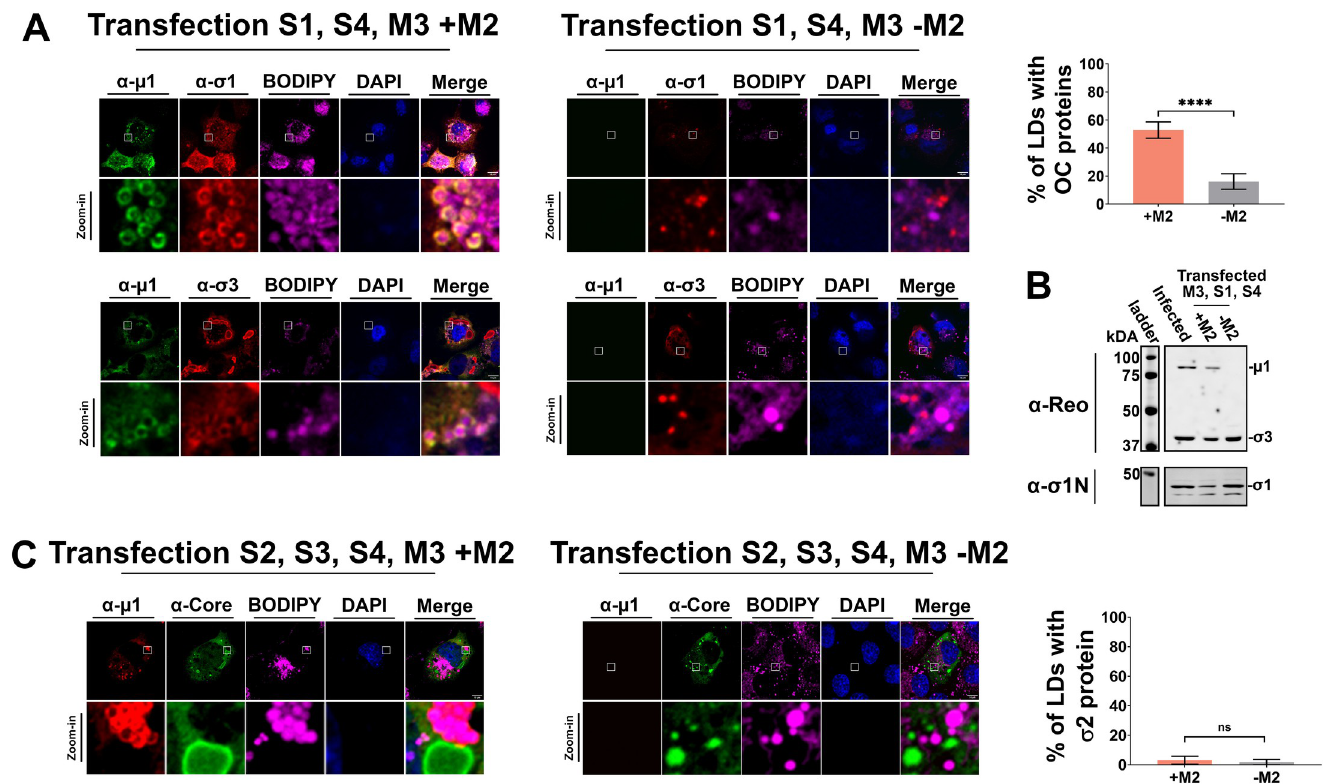
Fig 4. Reovirus outercapsid proteins localize to lipid droplets and perinuclear regions. (A-B) H1299 cells were transfected with S1pcDNA3 ( σ 1), S4pcDNA3 ( σ 3), and M3pcDNA3 ( μ NS) with or without M2pcDNA3 ( μ 1). (A, Left) Immunofluorescence staining was conducted with antibodies specific to OC proteins μ 1 (monoclonal 10F6) and σ 1 (monoclonal G5 directly labelled with AlexaFluor 647) (top) or μ 1 (10F6) and σ 3 (monoclonal 10C1 directly labelled with AlexaFluor 647) (bottom), BODIPY for LDs, and DAPI staining for nuclei. μ 1 was detected with secondary antibodies conjugated to AlexaFluor 488. ( A, Right ) The number of LDs co-staining with σ 1 or σ 3 were quantified and plotted as a percentage of the total number of LDs for both cells transfected with or without M2pcDNA3 (+ or–M2). (B) Cell lysates were subjected to SDS-PAGE followed by Western blot analysis with either polyclonal antibodies raised against whole virus ( α -Reo, top) or ( α - σ 1N, bottom) to determine the extent of gene silencing. ( C, Left) H1299 cells were transfected with S2pcDNA3 ( σ 2), S3pcDNA3 ( σ NS), S4pcDNA3 ( σ 3), and M3pcDNA3 ( μ NS) with or without M2pcDNA3 ( μ 1). Immunofluorescence staining was conducted with antibodies specific to OC protein μ 1 (monoclonal 10F6) and polyclonal rabbit antibodies raised against reovirus cores ( α -Core), BODIPY for LDs, and DAPI staining for nuclei. μ 1 was detected with secondary antibodies conjugated to AlexaFluor 647, and core protein σ 2 with secondary antibodies conjugates to AlexaFluor 488. ( C, Right ) The number of LDs co-staining with σ 2 were quantified and plotted as a percentage of the total number of LDs for both cells transfected with or without M2pcDNA3 (+ or–M2). Represented images were created from Z-stacks acquired using immunofluorescent spinning disk confocal microscopy. Images are representative of at least five images captured for each condition from three biologically independent experiments. Data is plotted as mean +/- 95% CI. Statistical analysis is reported as unpaired t-test between the mean of each column. ���� p < 0.0001, ��� p < 0.001, �� p < 0.05, ns >